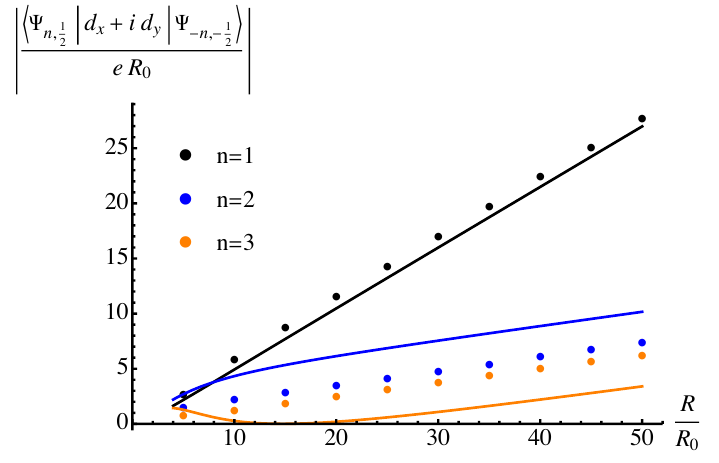
+ id Figure 6: The magnitude of the matrix element of d + = d for the transition x y | Ψ 〉 → | Ψ 〉 for n = 1,2, and 3 as a function of the radius and setting − n , − 1 / 2 n ,1 / 2 L = 5 R . The points are obtained by means of the numerical tight-binding model 0 = 0.25 R = 0.05 R with discretisation constants a and a r z 0 0